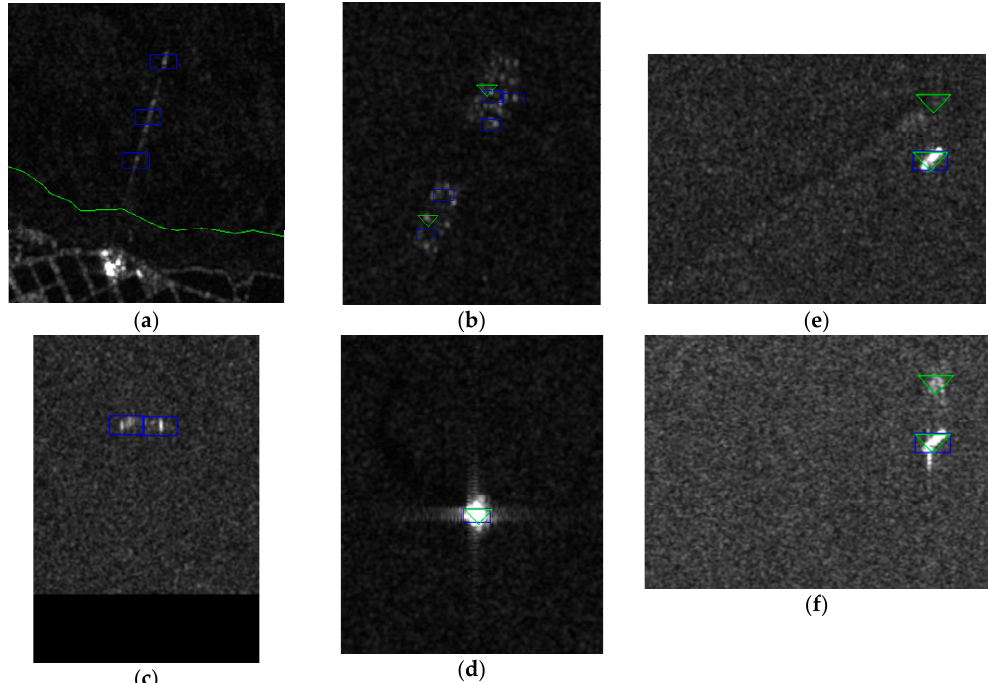
Figure 7. Some types of false alarms in the example image. A blue rectangle is a detection in VV, a green triangle in VH. Except for ( f ), the VV channel is shown. ( a ) Coastal infrastructure outside the land mask (green line). ( b ) Aquaculture structures. ( c ) Azimuth ambiguity of a ship that is outside the image. The image edge can be seen at the bottom. ( d ) Non-AIS-reporting oil platform. ( e ,f) Detected ship plus false alarm on the cross-pol signature of the ship’s wake (( e ) VV image; ( f ) VH image). Orientation as in Figure 5, i.e., azimuth direction upward, range to the right.